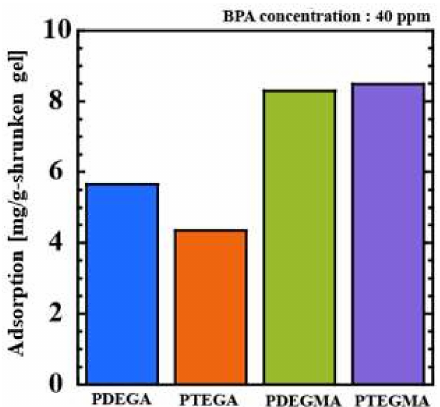
Figure 6. Adsorption of BPA by the POEGA and POEGMA gels.